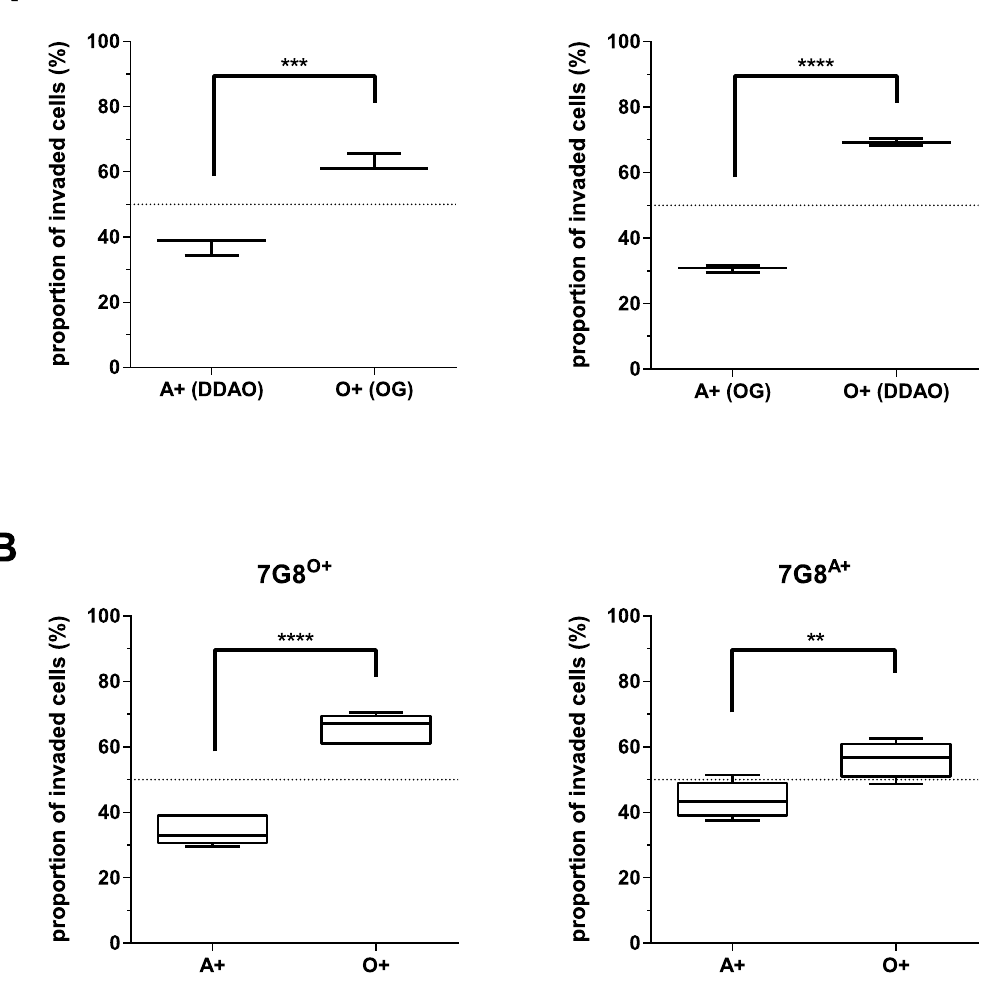
Figure 5. The preference of Plasmodium falciparum strain 7G8 invasion for O + erythrocytes is independent of fluorescent label or previous culture conditions. Erythrocytes from one individual each of blood group A + and O + , labelled with DDAO or OG respectively, were co-incubated with P. falciparum strain 7G8 for 48 h to allow rupture of schizonts and subsequent invasion of labelled erythrocytes. ( A) The impact of the cell label staining on erythrocyte preference was tested by comparing invasion rates when A + erythrocytes were labelled with DDAO and O + erythrocytes labelled with OG, or when the same erythrocyte samples were labelled in the opposite combination, A + being labelled with OG and O + with DDAO. ( B ) P. falciparum strain 7G8 parasites were cultured in blood group O + (7G8 O + ) or A + (7G8 A + ) erythrocytes for > 2 weeks before carrying out an erythrocyte preference assay, to determine whether impact of previous culture conditions on erythrocyte preference. In both cases statistical significance was determined using unpaired t test ( ** p < 0.01, *** p < 0.001, **** p <